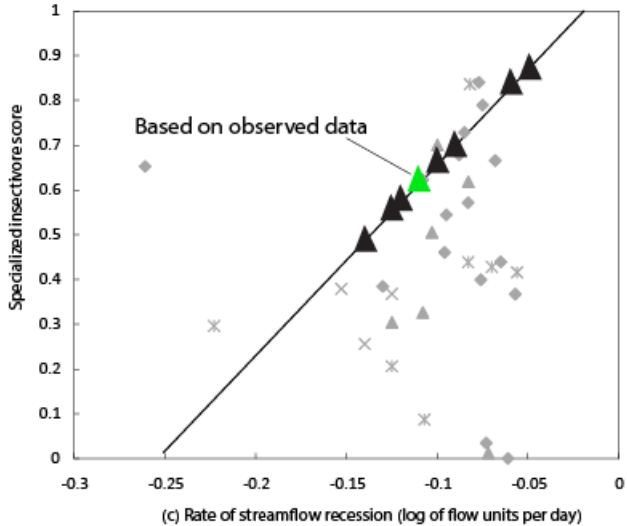
Figure 6. Example of an ecological flow application by comparison of estimated values for three streamflow characteristics for site 13 (03488000) (Table 1, Figure 1) and calibration period 1 (Cal1). ( a ) Constancy; ( b ) Frequency of moderate flooding (number per year) and ( c ) Rate of streamflow recession (log of flow units per day). Black triangles represent model estimated values based on the seven objective functions. Green triangle represents streamflow characteristics based on observed data. Values for RA7 (Rate of streamflow recession) were multiplied by negative 1 to convert values to those in the original analysis. Thin black lines represent 80th percentile quantile regression lines based on the 33 data point (grayed) in the background used by Knight et al. [41]. (Figure modified from Knight et al. [41]).